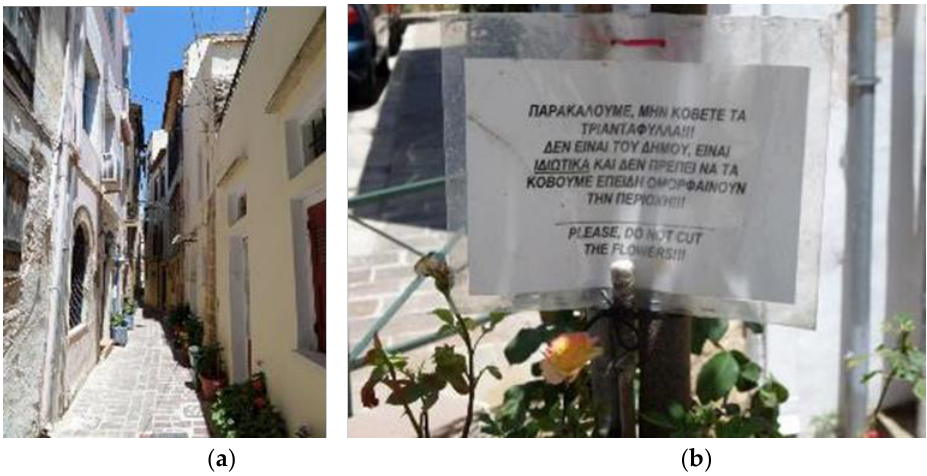
Figure 10. ( a ) A narrow street in the historic center of Chania. ( b ) Zoom on a request written by inhabitants asking tourists to respect “private” goods e.g., flowers!